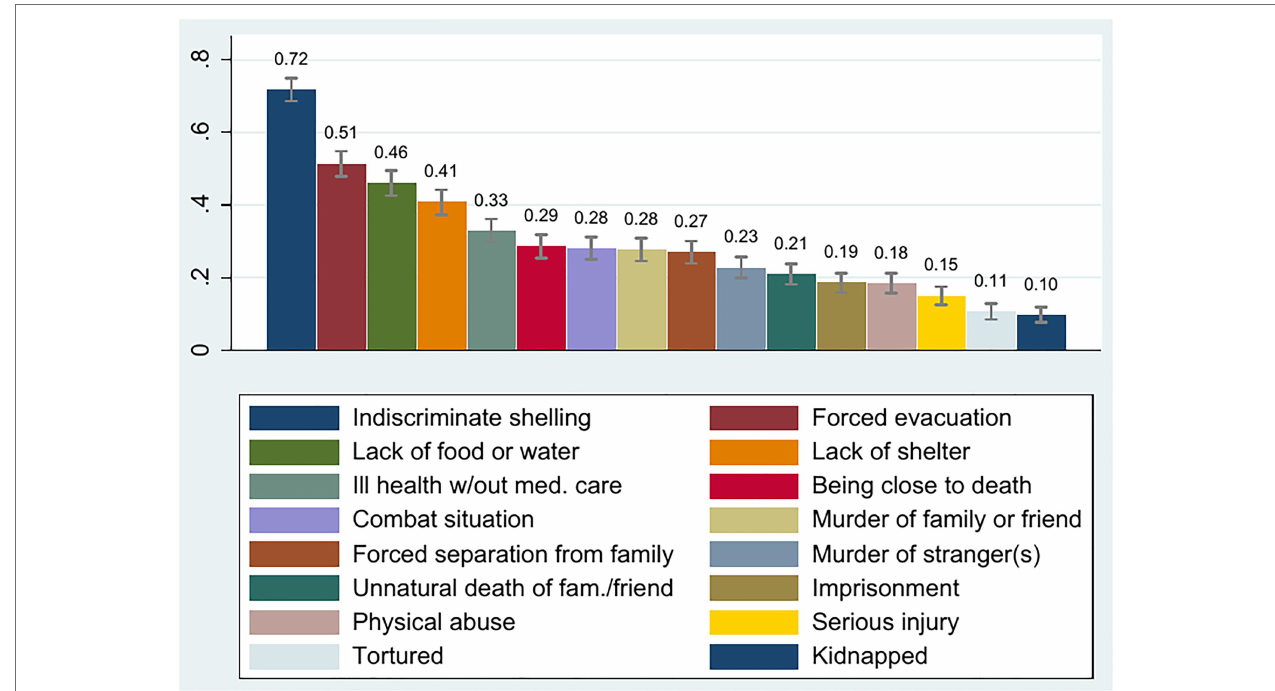
FIGURE 1 | Sixteen items of the Harvard Trauma Questionnaire. Capped ranges indicate 95% confidence